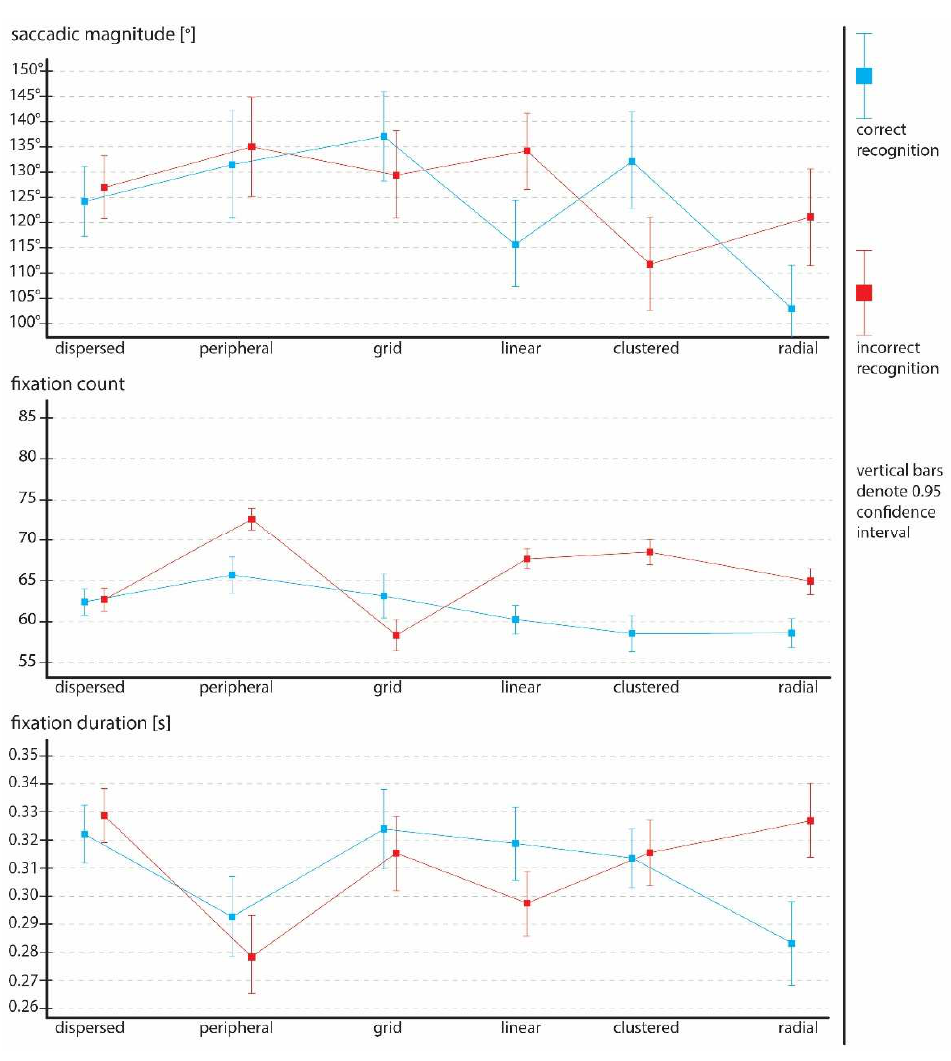
Figure 5. 3 Spatial analysis of participants' visual behavior.